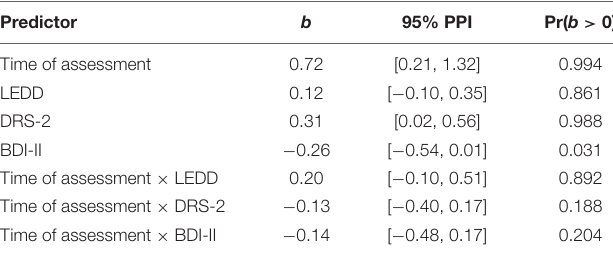
TABLE 2 | Fixed effect parameters of the ordered-logit generalized linear mixed